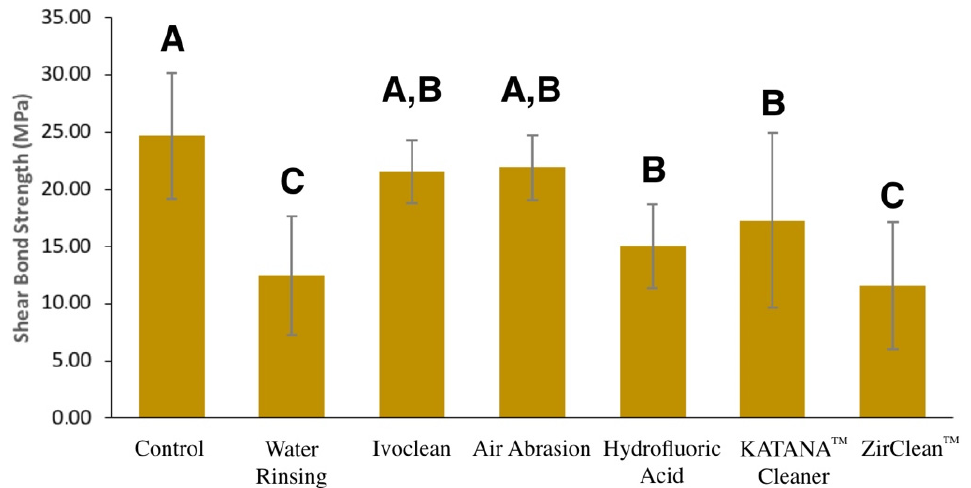
Figure 4. Shear bond strength of self-adhesive resin cement to saliva and silicone indicating paste-contaminated zirconia that had been exposed to different cleaning methods. Data are mean ± standard deviations. Vertical bars labeled with the same letter indicate no significant difference ( p > 0.05).